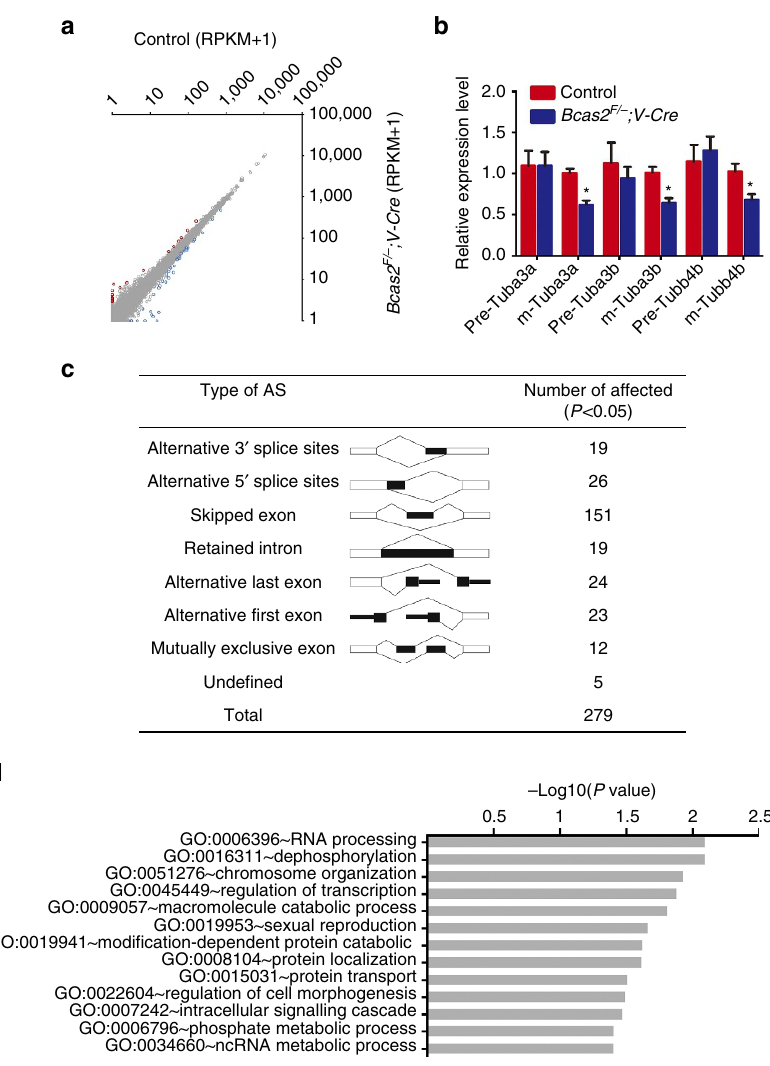
Figure 5 | Global analysis of Bcas2 -mediated alternative splicing (AS). ( a ) Scatter plot of significantly differentially expressed transcripts in Bcas2 F/ (cid:2) ;Vasa-Cre testes compared with the controls. Blue dots represent significantly down-regulated transcripts, while red dots show significantly up-regulated transcripts ( P o 0.05, fold-change of RPKM 4 1.5). Grey dots illustrated unchanged transcripts. ( b ) Real-time RT-PCR analysis of Pre-mRNA and mature (m) mRNA expression level of Tuba3a , Tuba3b and Tubb4b in control and Bcas2 F/ (cid:2) ;Vasa-Cre testes of P9 mice with Gapdh as the internal control (* P o 0.05, n ¼ 5). Error bars represent s.e.m. The pre-mRNA primers were designed in one of the exons and the adjacent intron and the mature mRNA primers were designed to span an exon-exon junction. ( c ) Seven AS events significantly affected by depletion of BCAS2 in the testes at P9. The simple diagrams of seven AS events recognized by ASD software and splicing events affected by depletion of BCAS2 analysing the RNA-seq data using ASD software ( P o 0.05). ( d ) GO term enrichment analysis of genes with significantly affected AS between Bcas2 F/ (cid:2) ;Vasa-Cre and Dazl null mice prompted us to